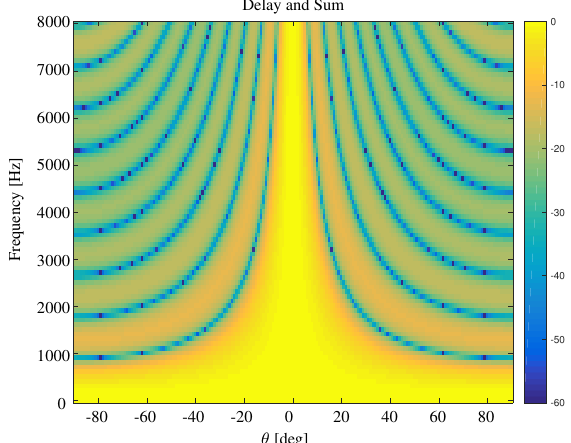
Figure 2. Beampattern using delay-and-sum beamformer. M = 11, δ = 3.5